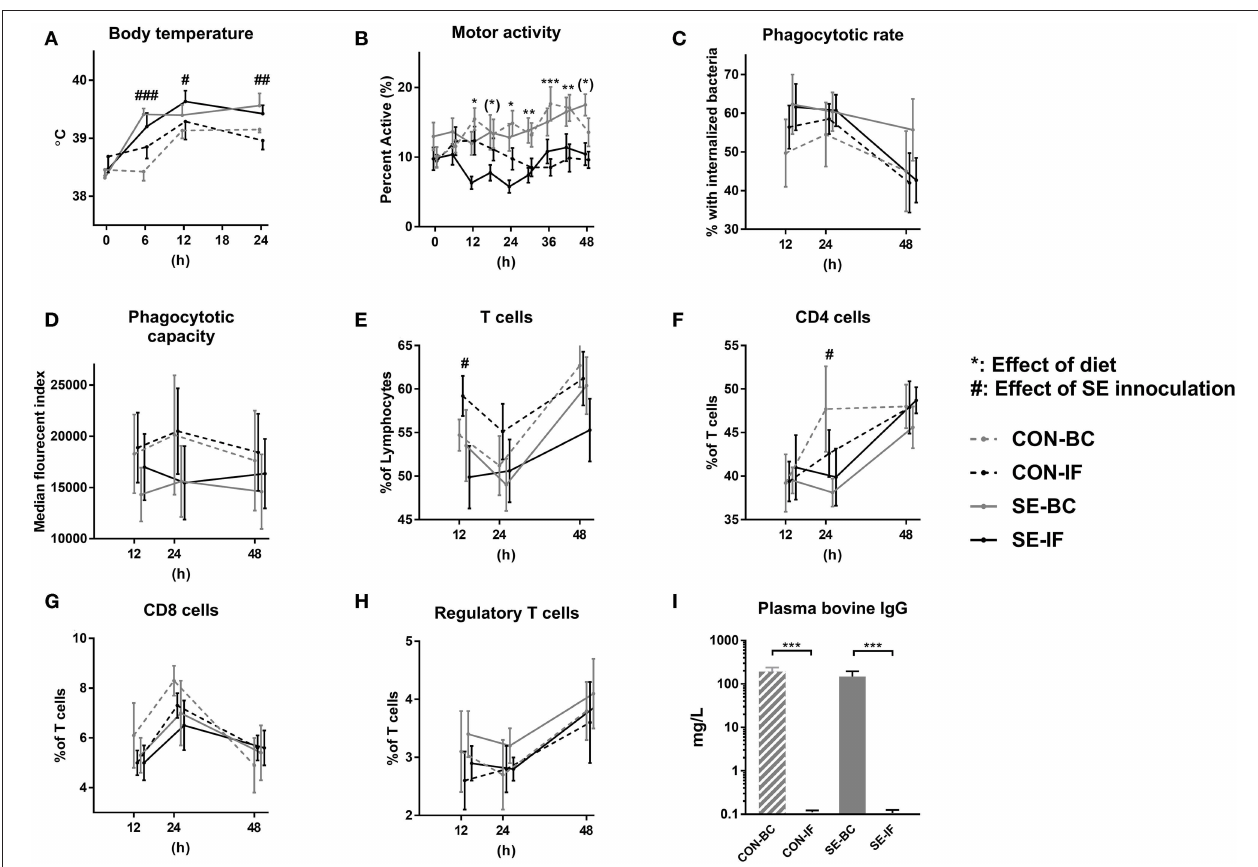
FIGURE 3 | Two days of bovine colostrum feeding has no impact on response to Staphylococcus epidermidis bacteremia. Results of Experiment 3 comparing preterm pigs infused with Staphylococcus epidermidis (SE) or saline (CON) at day 3, after being infused with maternal plasma and fed bovine colostrum (BC) or infant formula (IF) from after birth. (A) Body temperature 0–48h post inoculation. (B) Motor activity, shown as the fraction of time with physical activity at 0–48h post inoculation. (C) Neutrophil phagocytic rate 12–48h post inoculation, defined as fraction of neutrophils with internalized bacteria. (D) Neutrophil phagocytic capacity 12–48h post inoculation, defined as median fluorescent index of neutrophils with internalized bacteria. (E) T cells 12–48h post inoculation, defined as fraction of CD3 positive lymphocytes. (F) CD4 cells 12–48h post inoculation, defined as the CD4 positive, CD8 and FOXP3 negative fraction of T cells. (G) CD8 cells 12–48h post inoculation, defined as the CD8 positive, CD4 and FOXP3 negative fraction of T cells. (H) Regulatory T cells 12–48h post inoculation, defined as the FOXP3 and CD4 positive, CD8 negative fraction of T cells. CD4 positive as fraction (I) Plasma levels of bovine immunoglobulin G (IgG) at euthanasia. (A–I) Presented as means with corresponding standard errors. #: Effect of SE ( p < 0.05), ##: Effect of SE ( p < 0.01), ###: Effect of SE ( p < 0.001), (*): Effect of diet ( p ≤ 0.1 ≥ 0.05), *: Effect of diet ( p < 0.05), **: Effect of diet ( p < 0.01), ***: Effect of diet ( p <